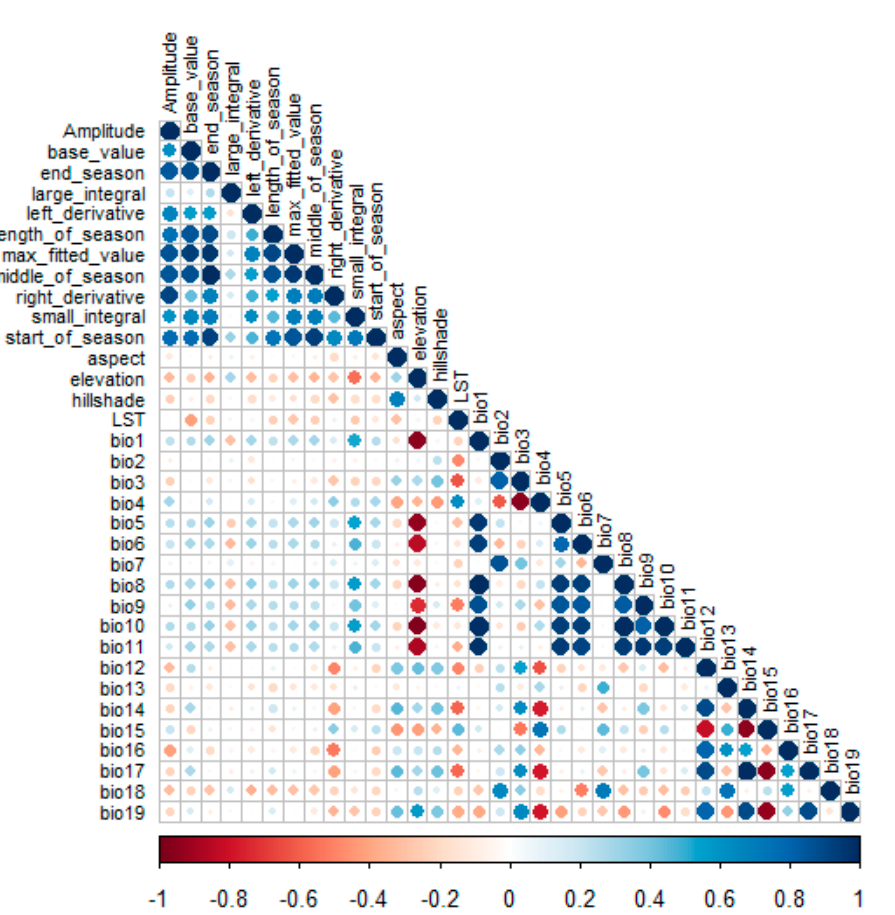
Figure 2. Collinearity matrix for predictor variables. Darker shades of blue and red colors indicate high variable collinearity while light shades indicate low collinearity between variables.